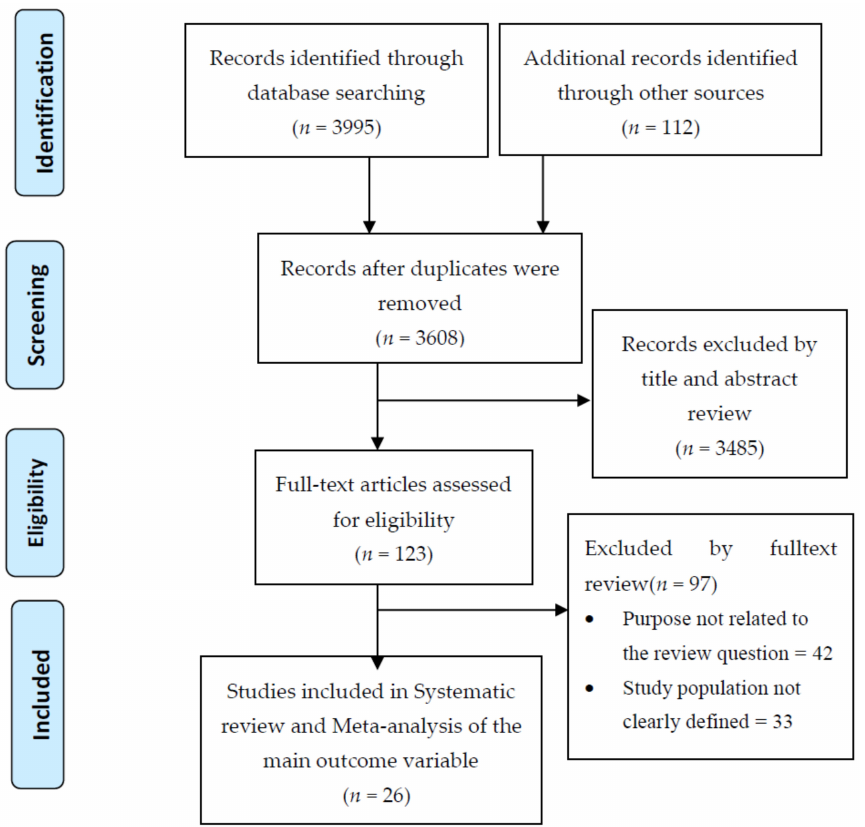
Figure 1. PRISMA flow diagram shows the searching strategy and screening of eligible